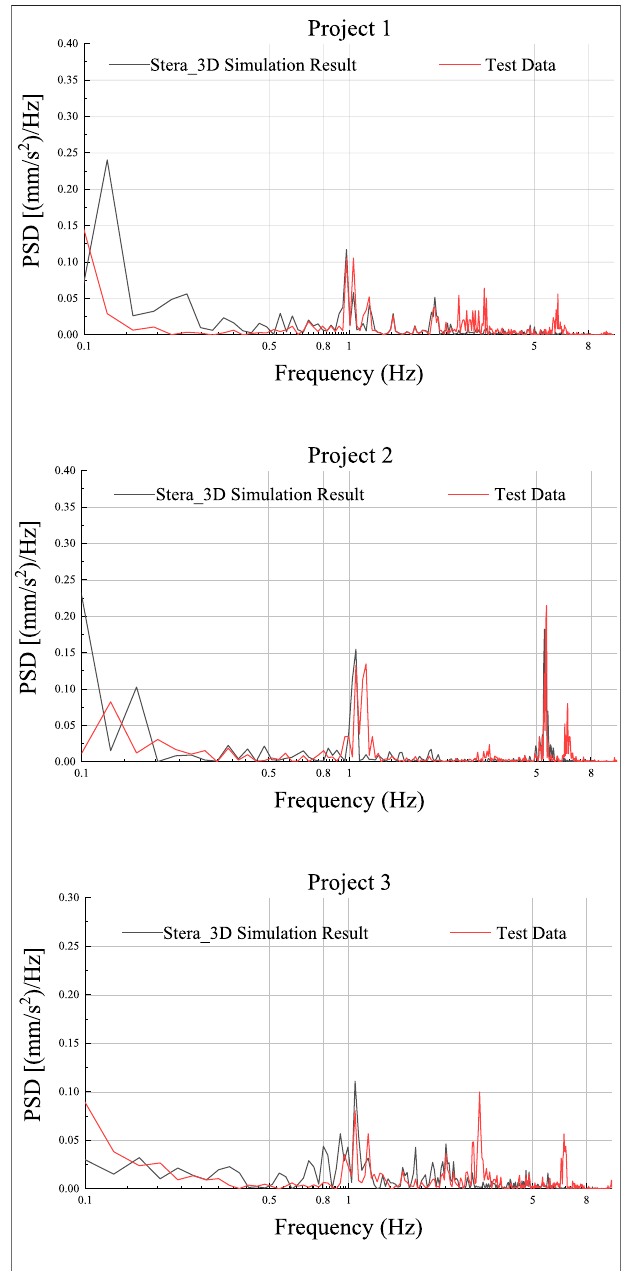
FIGURE 9 | Comparison of Fourier amplitude spectra for the SPCC fl oating foundation vibration reduction system obtained via simulations and testing.